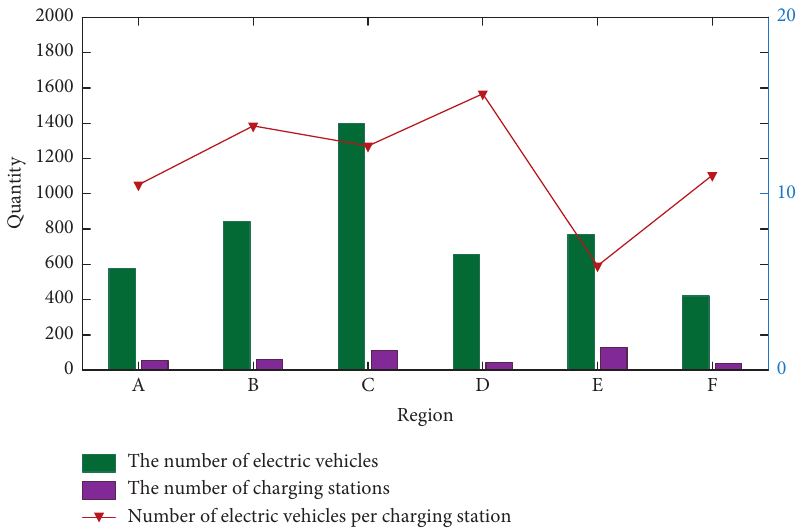
Figure 5: Contrast chart of electric vehicle ownership and charging